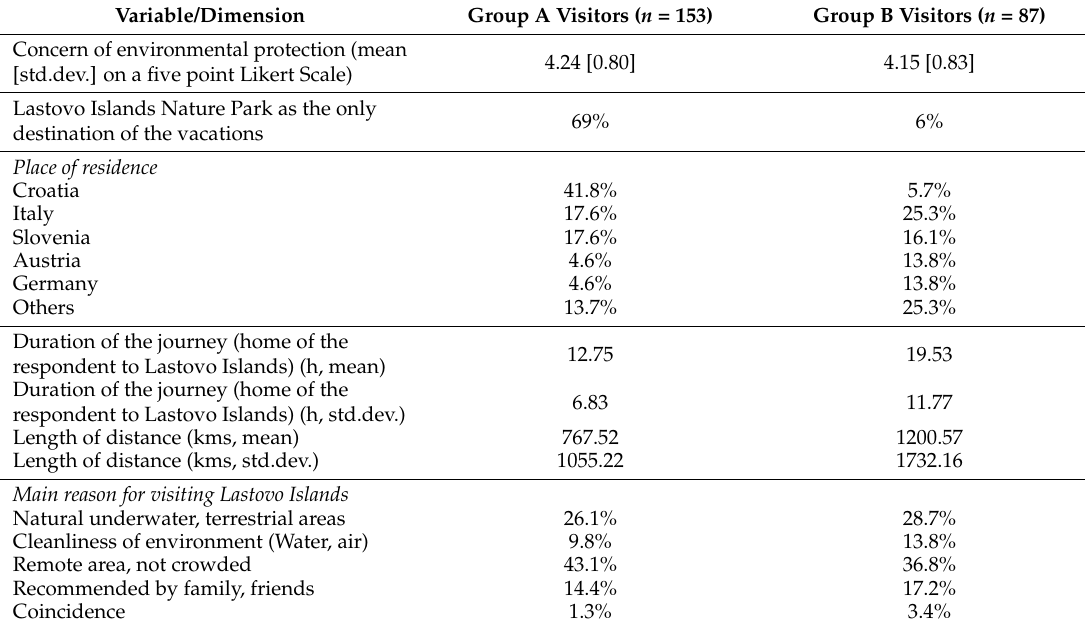
Table 2. Descriptive results: traveling to Lastovo